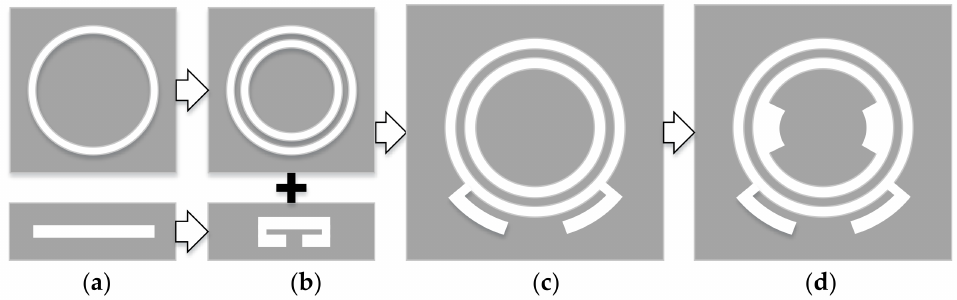
Figure 1. Antenna design stages. ( a ) antenna 1, ( b ) antenna 2, ( c ) antenna 3, ( d ) antenna